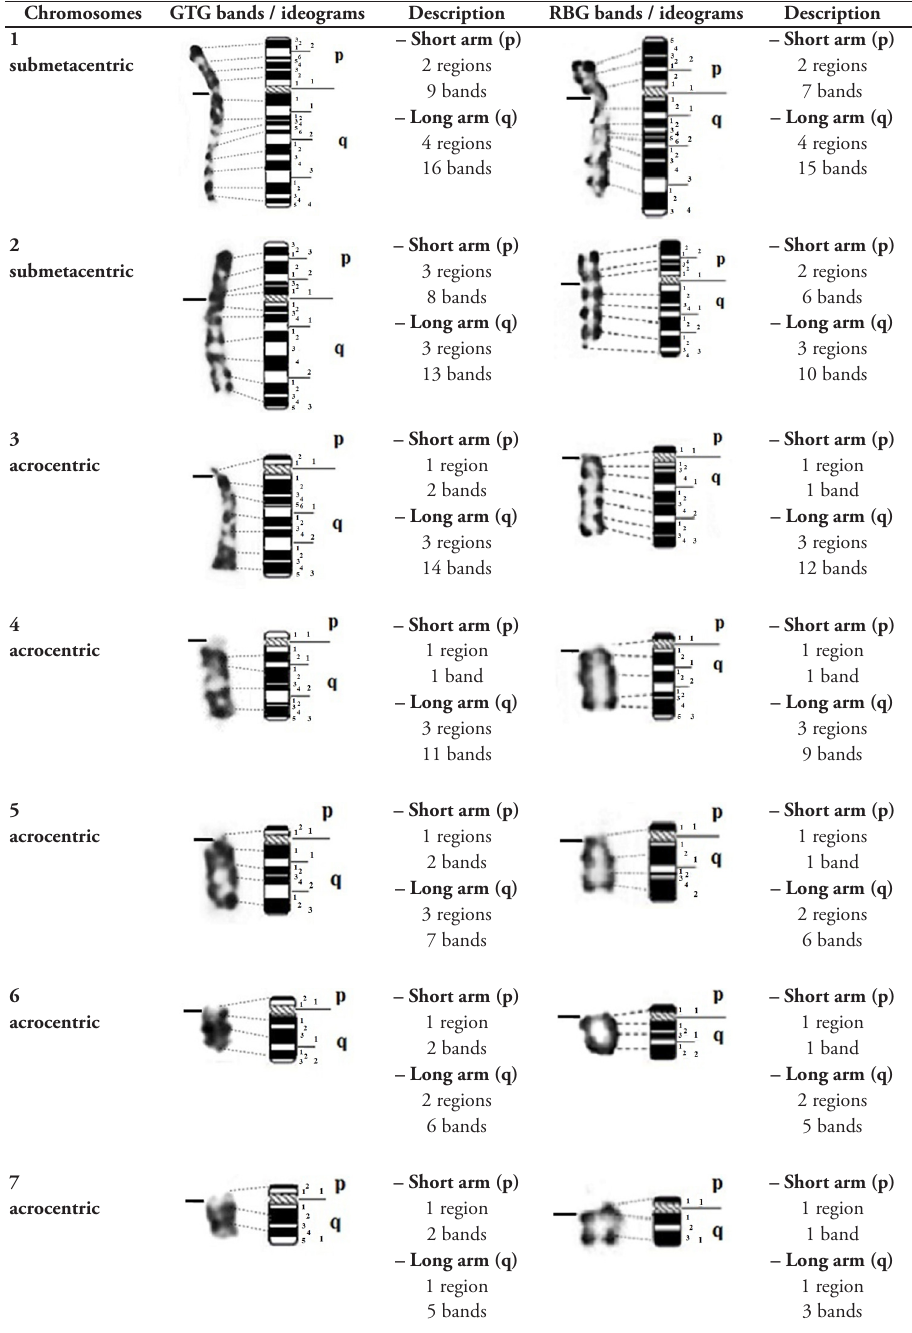
Table 1. Description of GTG and RBG bands on macrochromosomes and sex chromosomes ZW of the Houbara